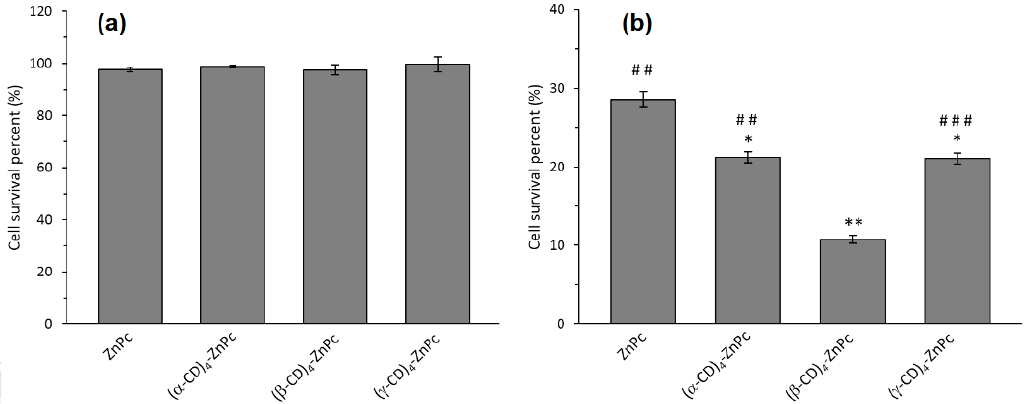
Figure 10. ( a ) Dark toxicity and ( b ) light toxicity of ZnPc, ( α -CD) 4 -ZnPc, ( β -CD) 4 -ZnPc, and ( γ -CD) 4 -ZnPc on Hela cells. For dark toxicity study, the cells were incubated for 24 h, and their survival percent were studied by 3-(4,5-dimethylthiazol-2-yl)-2,5-diphenyl tetrazolium bromide (MTT) assay. For light toxicity study, after 4 h of incubation by drugs (drug concentration was 5 µM, which was calculated by ZnPc), the cells were irradiated using 665 nm LED for 5 min, and then laid back into an incubator for 24 h before cell viability measurement by MTT assay (* p < 0.05, ** p < 0.01, host-guest complex vs. ZnPc. ## p < 0.01, ### p < 0.001 ZnPc, ( α -CD) 4 -ZnPc, and ( γ -CD) 4 -ZnPc vs. ( β -CD) 4 -ZnPc). Adapted from